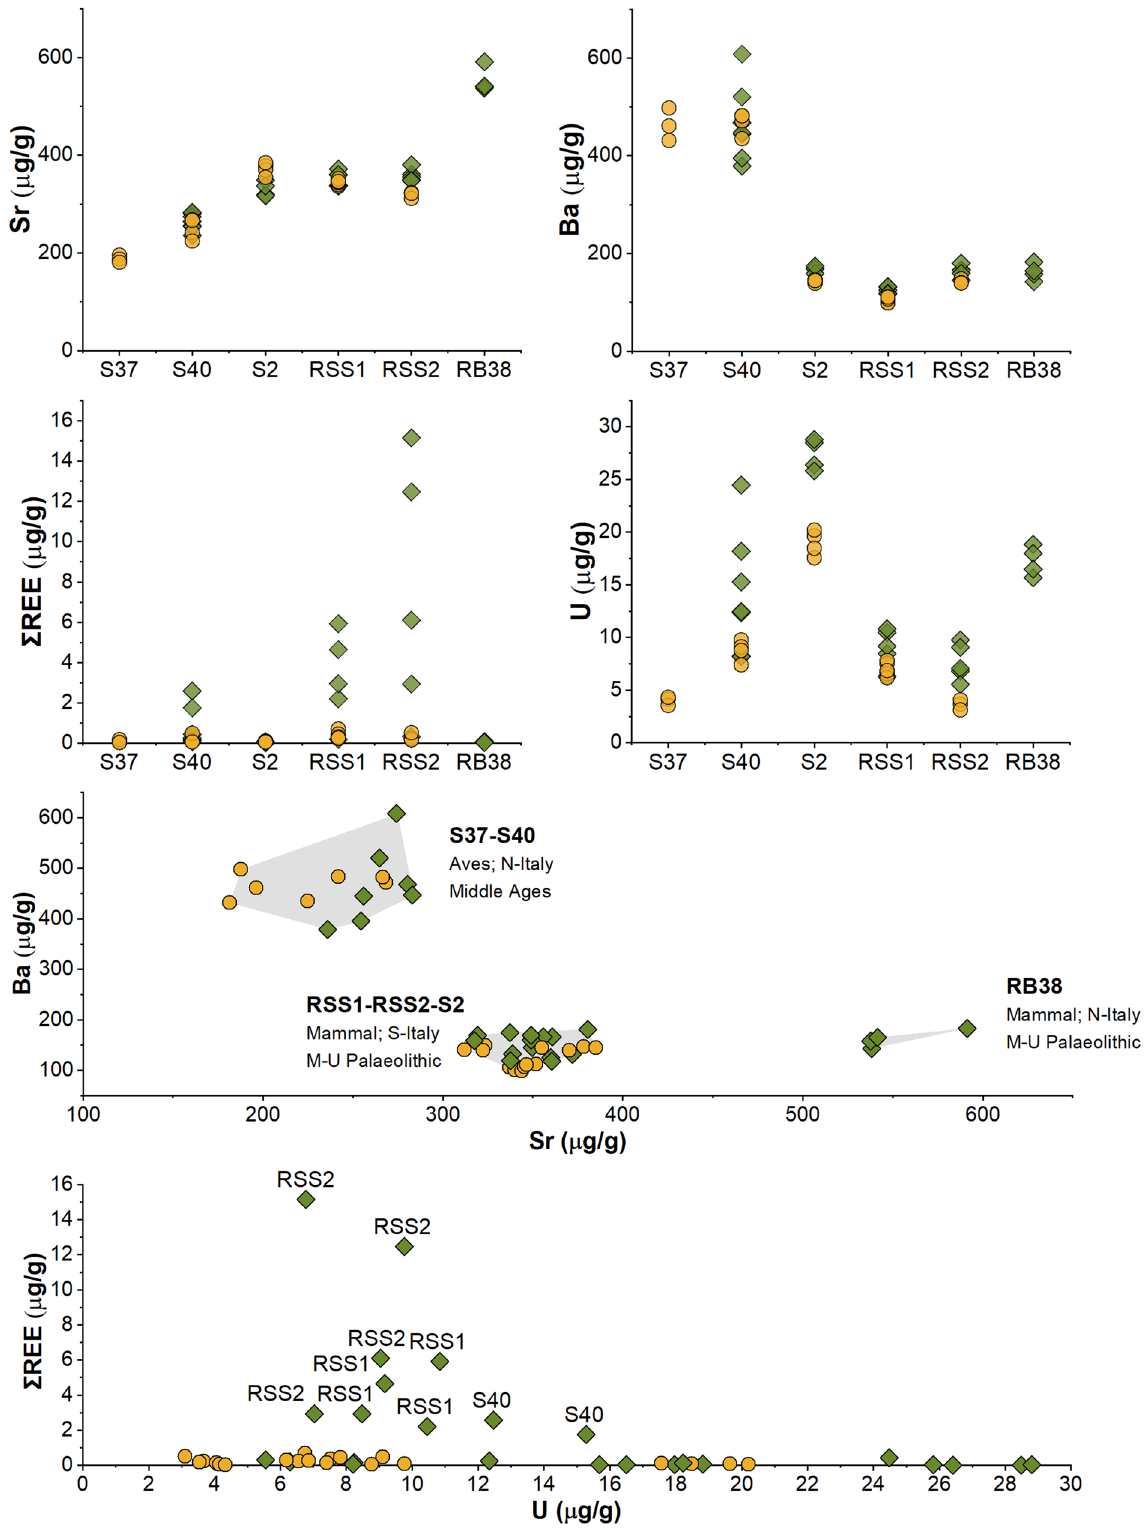
Figure 5. LA–ICP–MS spot analyses (ΣREE, U, Sr, Ba) on “high-” (orange circles) and “low-” (green diamonds) collagen areas of bone samples. These areas were visually selected based on CL images. A biplot of Ba vs. Sr content is reported to highlight inter-sample differences possibly arose in-vivo due to inputs such as diet, physiology, or local geology. A biplot of U vs. ΣREE content is also reported to highlight the t -test results, showing the differences correlated to high and low collagen content areas in the bone specimens. Error bars (2 SE) are smaller than symbol size. Two-standard errors are calculated based on repeated measures (n = 9) of NIST SRM 1400 bone ash (Sr: 4 µg/g; Ba: 19 µg/g; U: 0.1 µg/g; ΣREE: 0.35